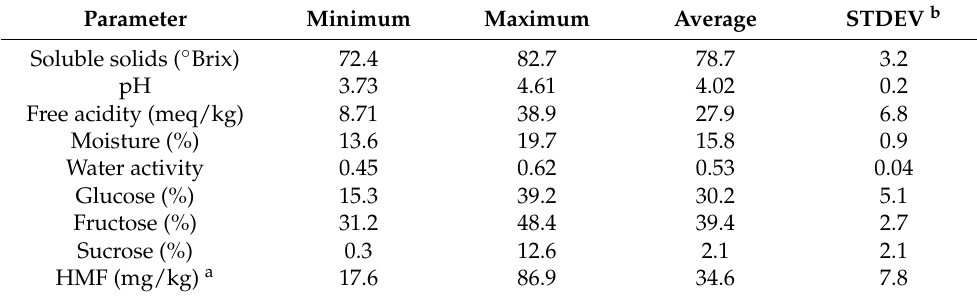
Table 1. Reference concentration levels for the measured quality traits in honey